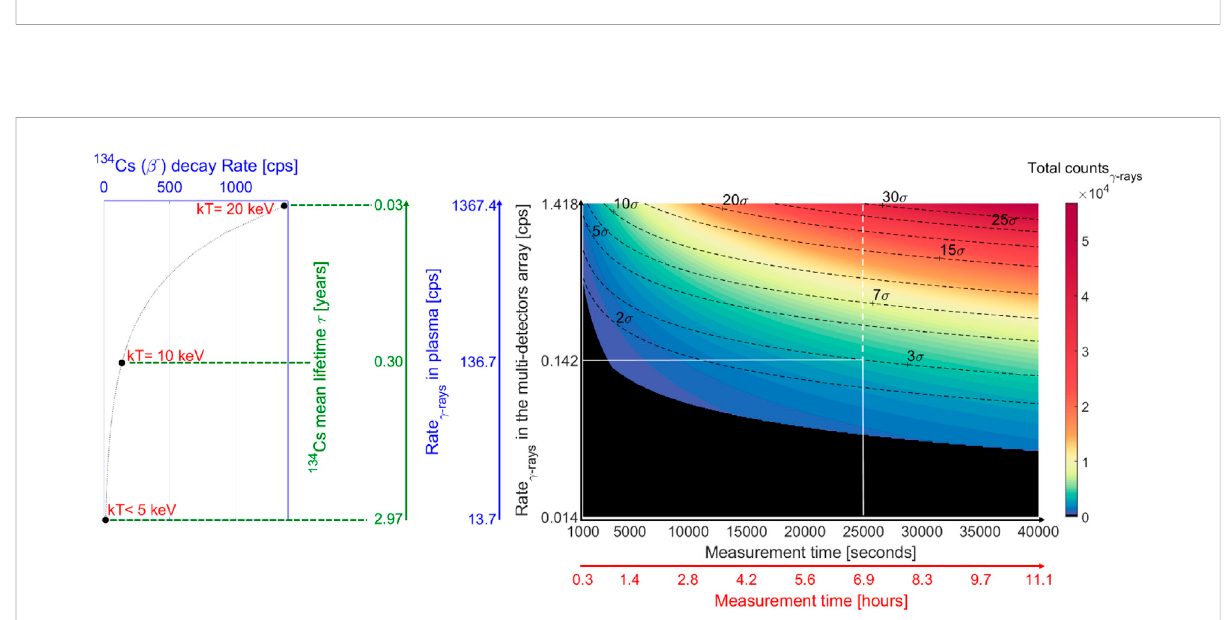
FIGURE 11 Total counts of gamma-rays emitted (pseudo-colors scale) and iso-signi fi cance contours (dashed lines) for different 134 Cs isotope lifetimes (green vertical axis) as a function of the measurement lifetime. Blue and black vertical scales show the predicted decay rate in plasma and the counting rate measured in the array associated to the different isotope